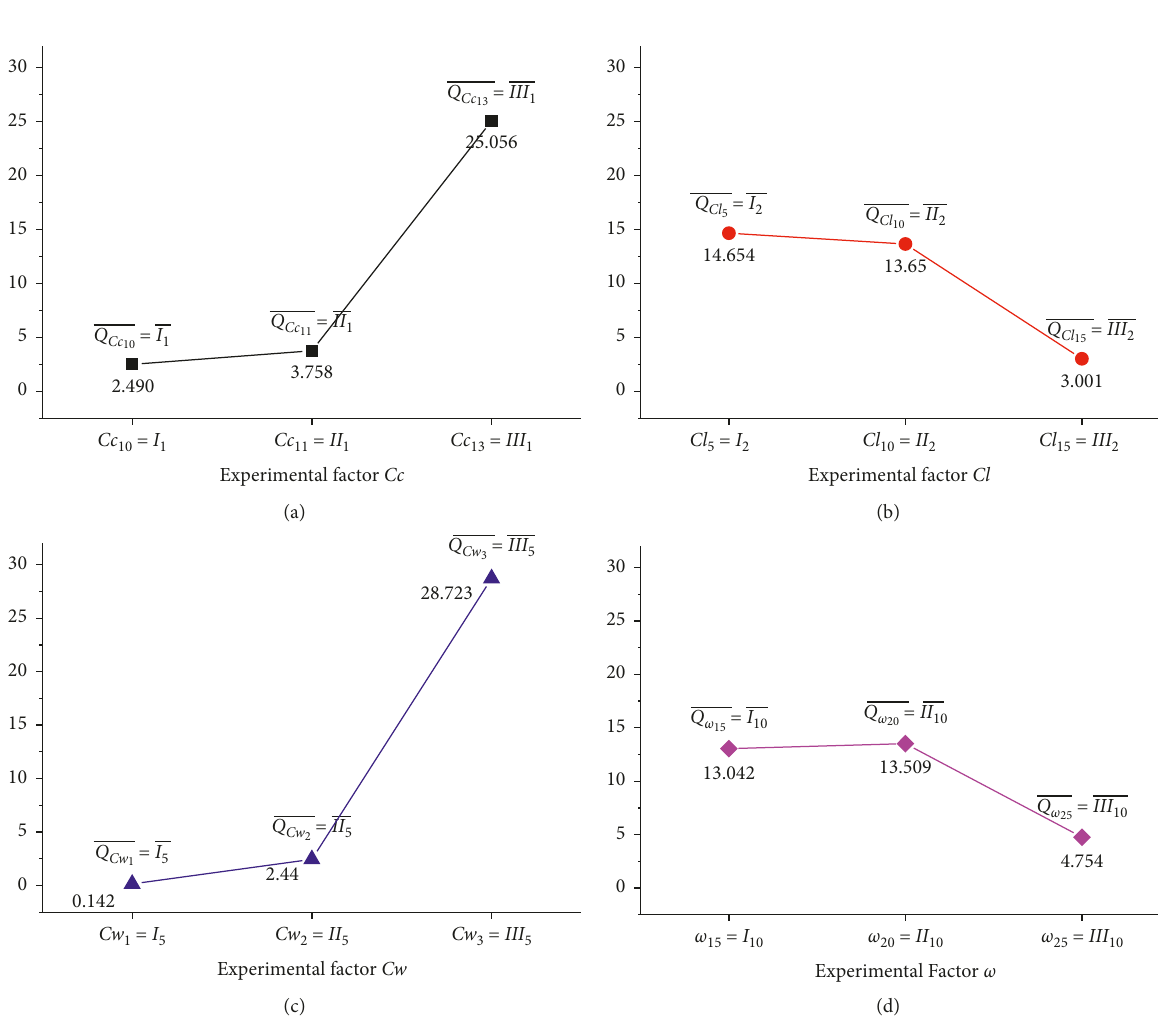
Figure 14: Relationship between the experimental factors and the rate of